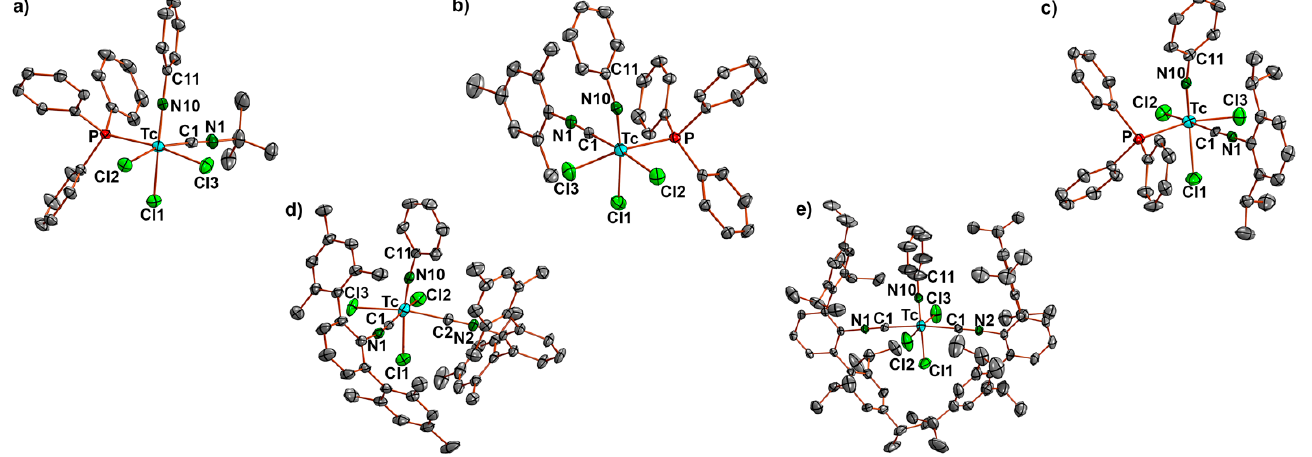
Figure 2. Ellipsoid representations of the molecular structures of ( a ) [Tc(NPh)Cl 3 (PPh 3 )(CN t Bu)] ( 2a ), ( b ) [Tc(NPh)Cl 3 (PPh 3 )(CNMes)] ( 2b ), ( c ) [Tc(NPh)Cl 3 (PPh 3 )(CNPh i-prop2 )] ( 2c ), ( d ) cis -